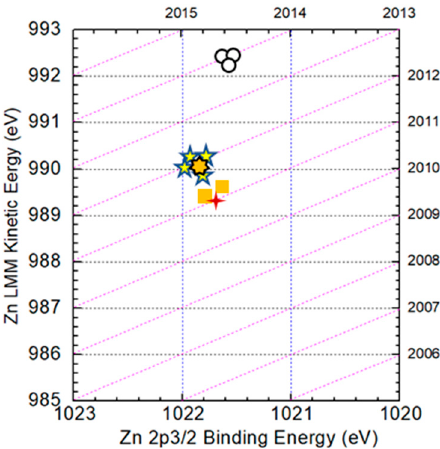
Figure 7. Auger parameters of Zn in Zn metal, CZTS and ZnS compounds. The ( ), ( ) and ( ) symbols show reference data of Zn metal, ZnS and CZTS in CZTS film, respectively. The ( ) symbol shows experimental data on the surface in this work. ( ) shows experimental data in the bulk of a CZTS film.